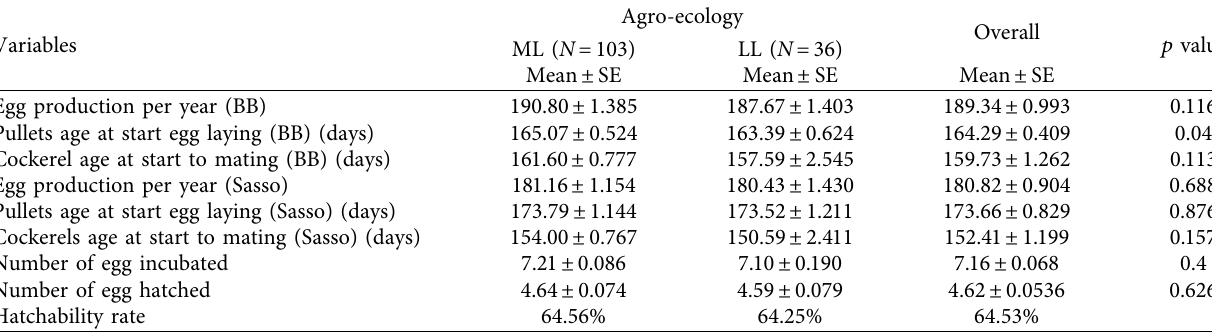
Table 2: Reproductive and productive performances of exotic